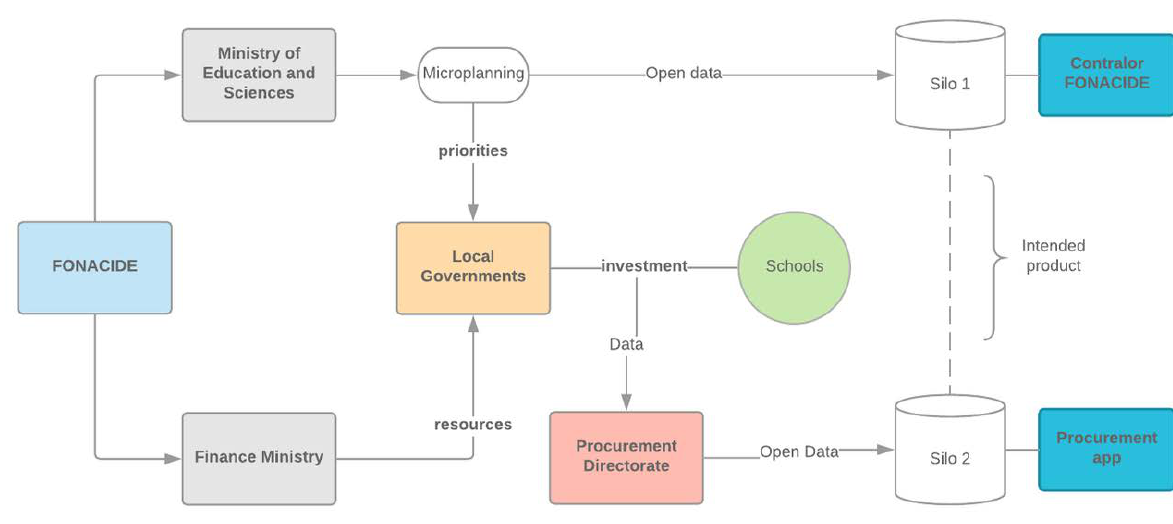
Figure 3: FONACIDE’s Data